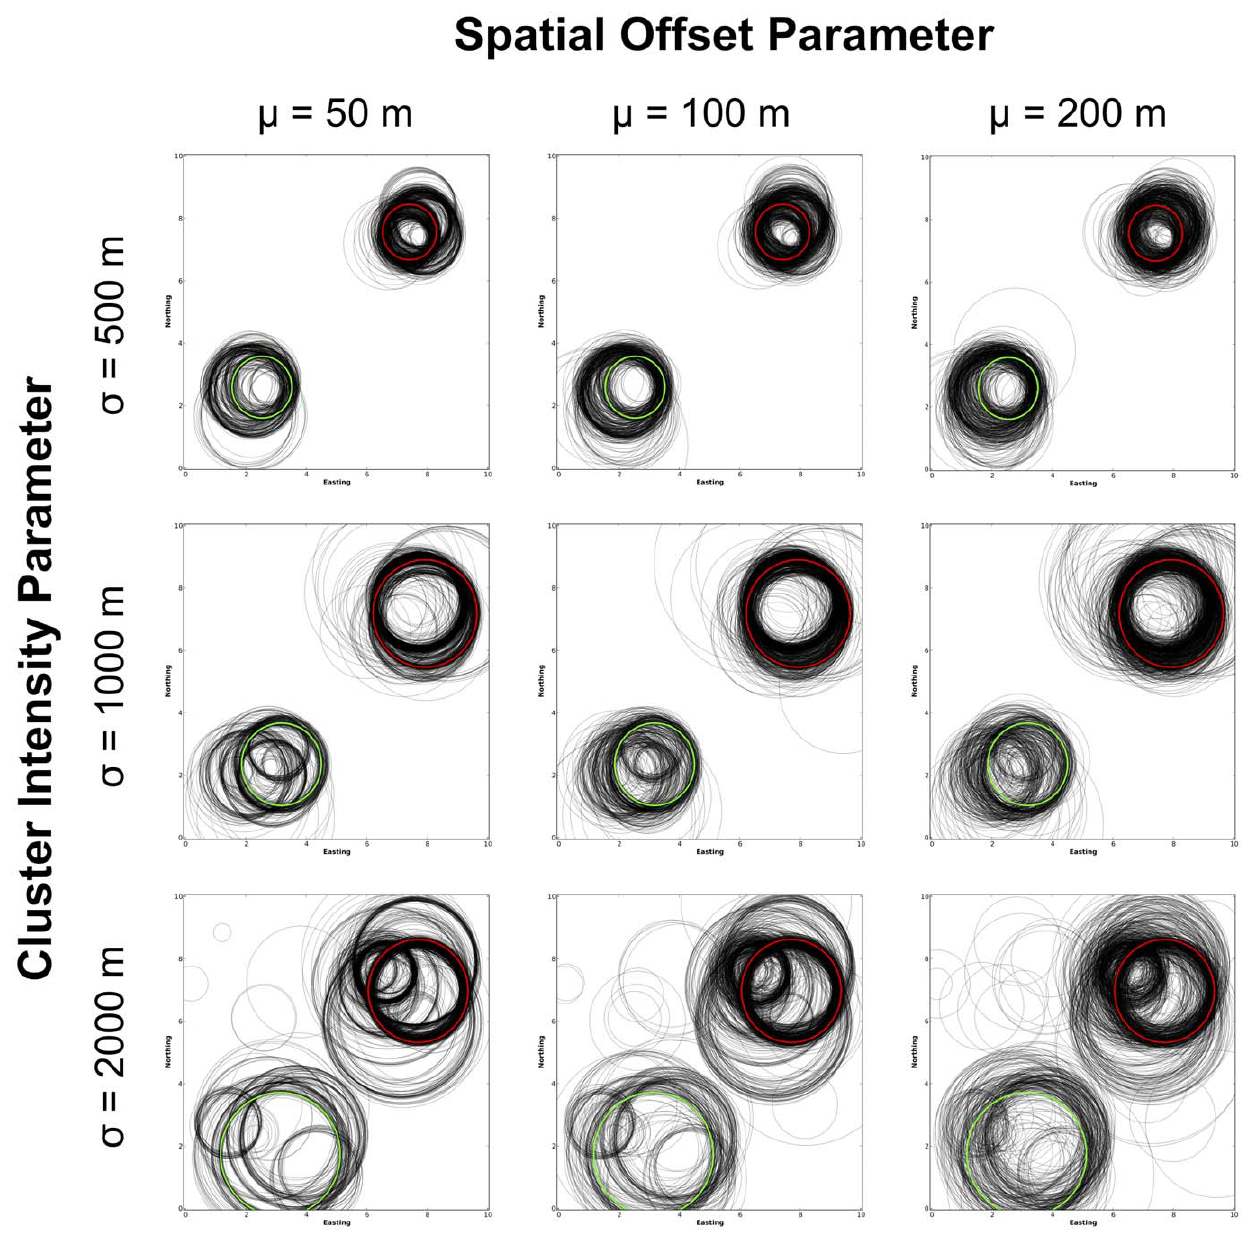
Figure 4. Plots of MLCs identified with the STPSS. The spatial footprint of the MLCs for the original datasets are shown in red and the secondary cluster with the next lowest p -value is shown in green. MLCs from perturbed versions of the same dataset are shown in black. The intensity of the original clusters decreases from the top down while the intensity of perturbation increases from the left to the right. This layout is followed in subsequent graphics.